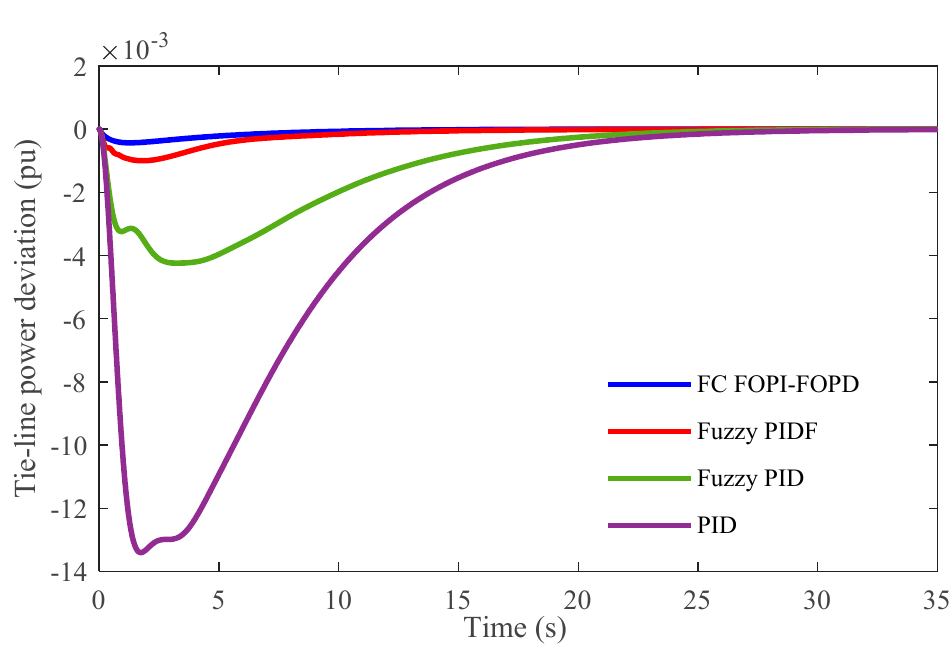
Figure 6. Tie line power variation.